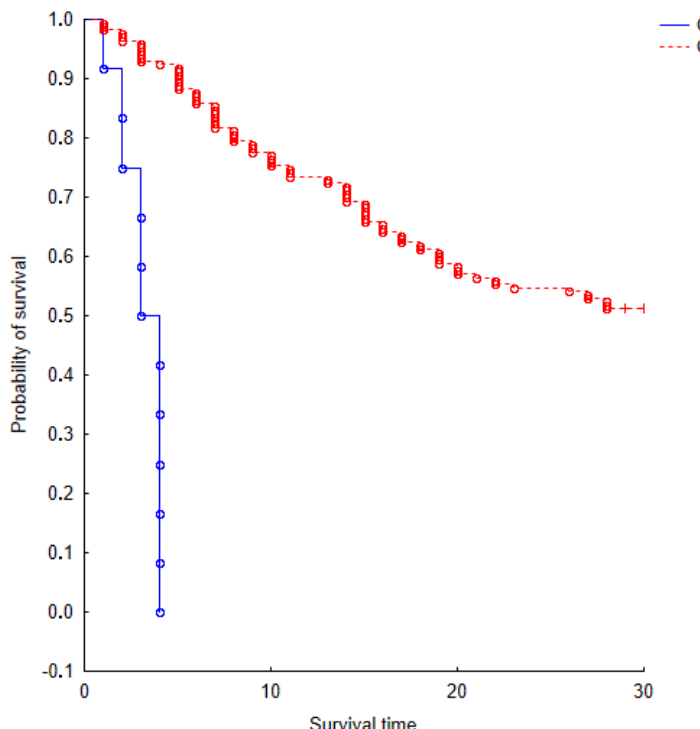
Figure 4. The Kaplan-Meier survival model for two groups of Activity Factors over a period of one month.